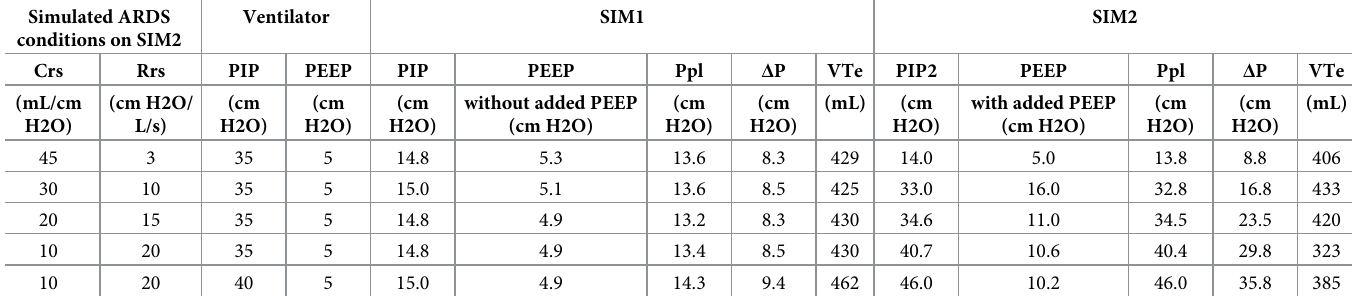
Table 5. Simulation of progressively worsening acute respiratory distress syndrome conditions on breathing simulator 2 during dual ventilation using the ACRA device. Simulated ARDS Ventilator SIM1 conditions on SIM2